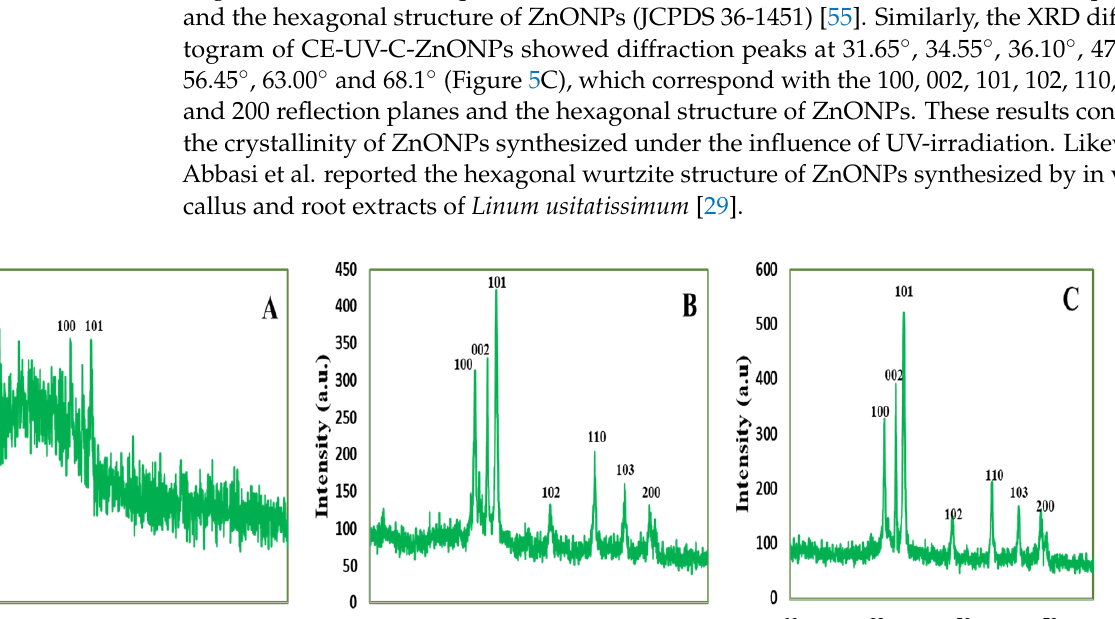
Figure 4. EDX spectra of ZnONPs ( A ) CE-ZnONPs ( B ) CE-UV-A-ZnONPs ( C ) CE-UV-C-ZnONPs.